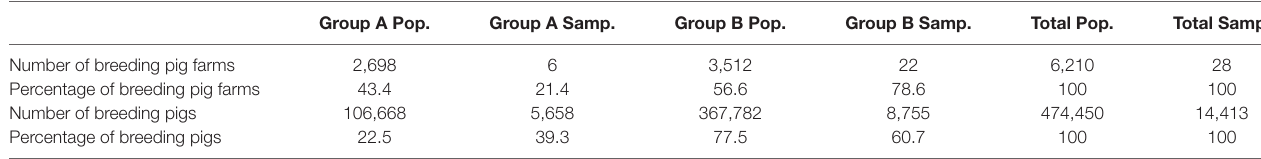
The whole population figure is based on the data collected in 2010 for England, Scotland, and Wales. The sample is based on the farms visited in Great Britain between 2015 and 2016.